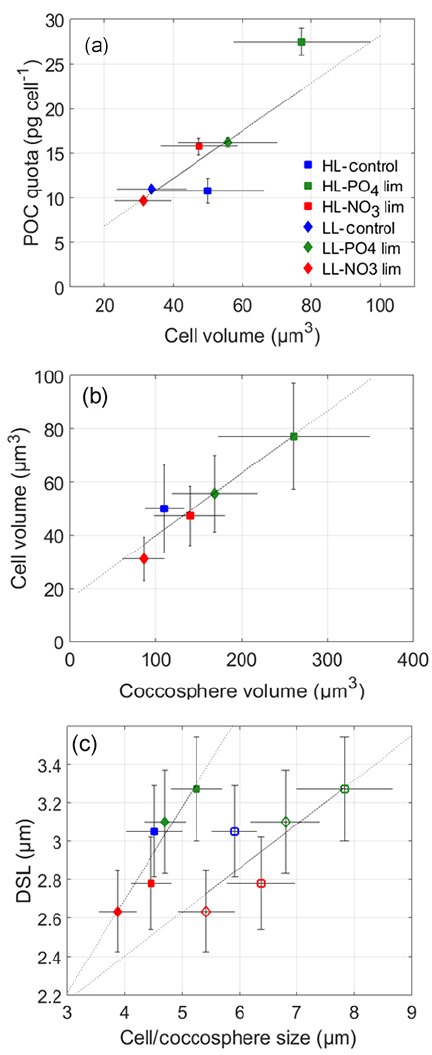
Figure 3. Cellular POC:PON (a) , POC:POP (b) and PIC:POC (c) ratios.